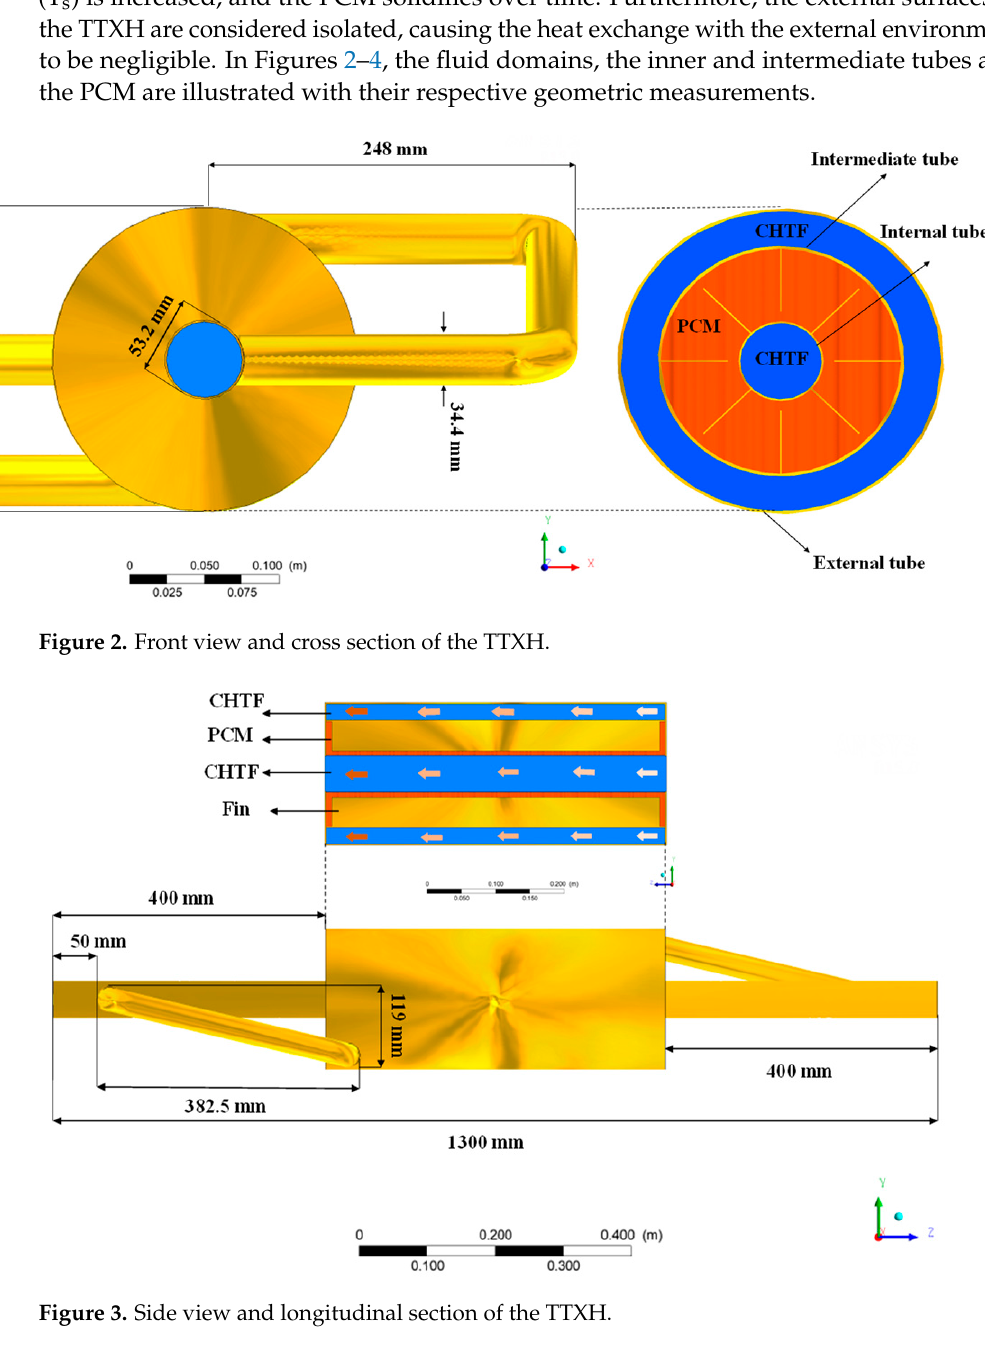
Figure 4. Isometric and frontal views of the fluid domain of the CHTF: inner and intermediate tubes. Due to the small thickness of the pipe and the isolation considered on the external surfaces of the TTHX, the solid material referring to the external pipe was neglected in the model for simplification purposes. Thus, as illustrated in Figure 5, only the CHTF, PCM, internal piping and intermediate piping were considered. Furthermore, the variation of 16 mm between the pipe length and the fins was also neglected, leaving only 480 mm of the TTHX length, which corresponded to the fins, considered in the simulation. These simplifications promoted the production of mesh of a reasonable quality.